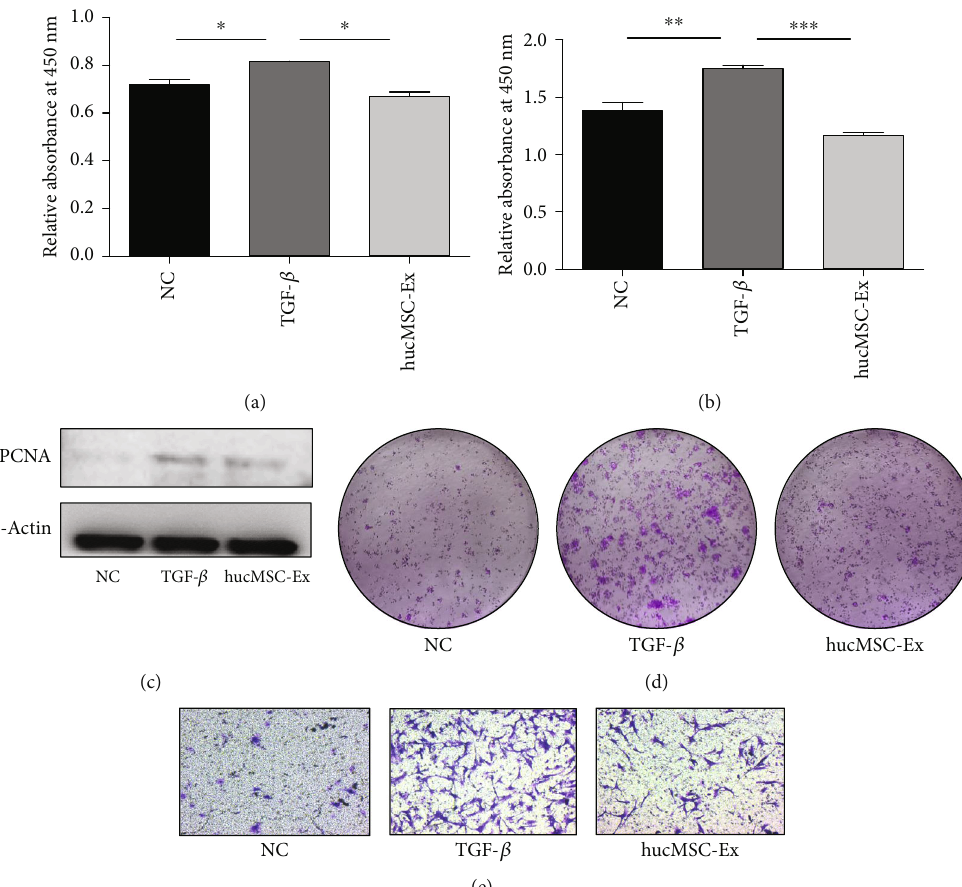
Figure 4: hucMSC-Ex inhibits human colonic fi broblast proliferation and migration. (a) CCK8 of intestinal fi broblasts after treatment for 24 hours, ∗ P < 0 : 05 . (b) CCK8 of intestinal fi broblasts after treatment for 48 hours, ∗∗ P < 0 : 01 and ∗∗∗ P < 0 : 0001 . (c) Western blot analysis of PCNA expression in intestinal fi broblasts after treatment for 48 hours. (d) The results of cloning experiment of intestinal fi broblasts for 14 days. (e) Transwell assay of intestinal fi broblasts after 18 hours of treatment